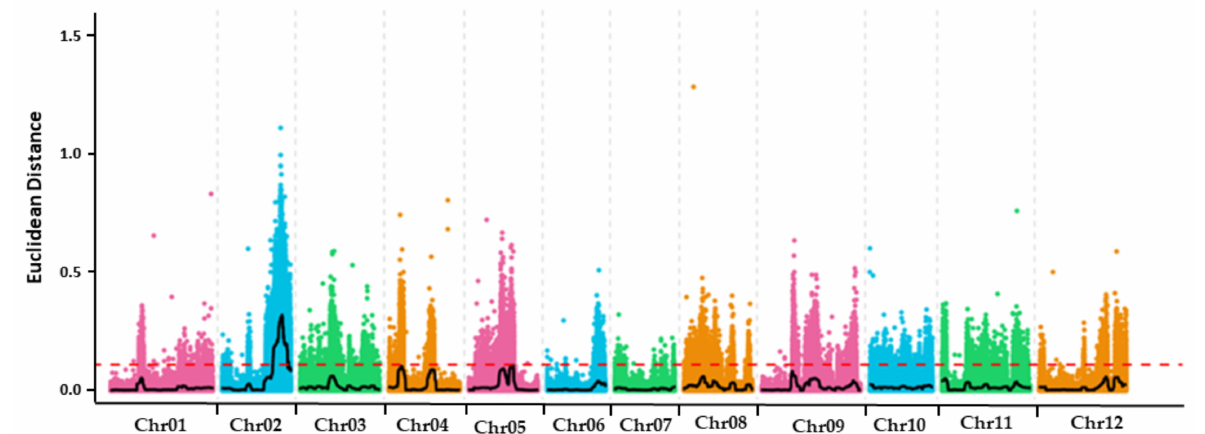
Figure 3. BSA location results of the SSC of wax gourd based on Euclidean distance (ED) association algorithm. The colored dots represent the ED value of each SNP, the black line represents the fitted ED value, and the red dotted line represents the significance association threshold.